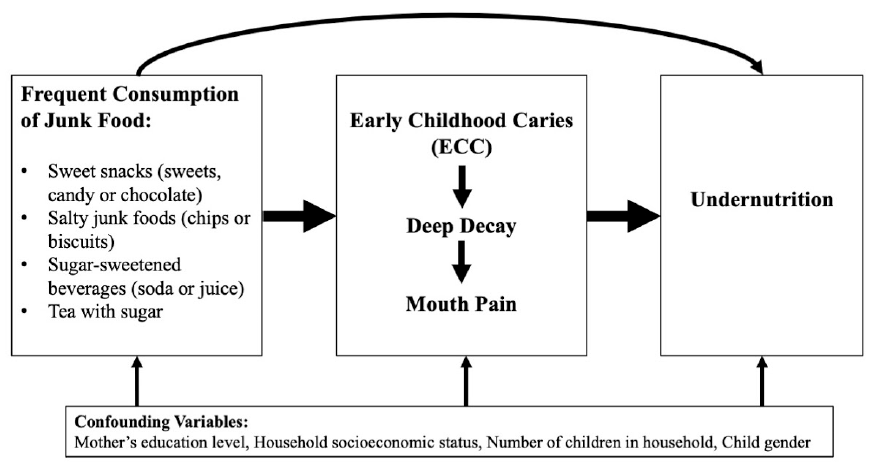
Figure 1. Conceptual model: Pathway from junk food consumption, early childhood caries to undernutrition.